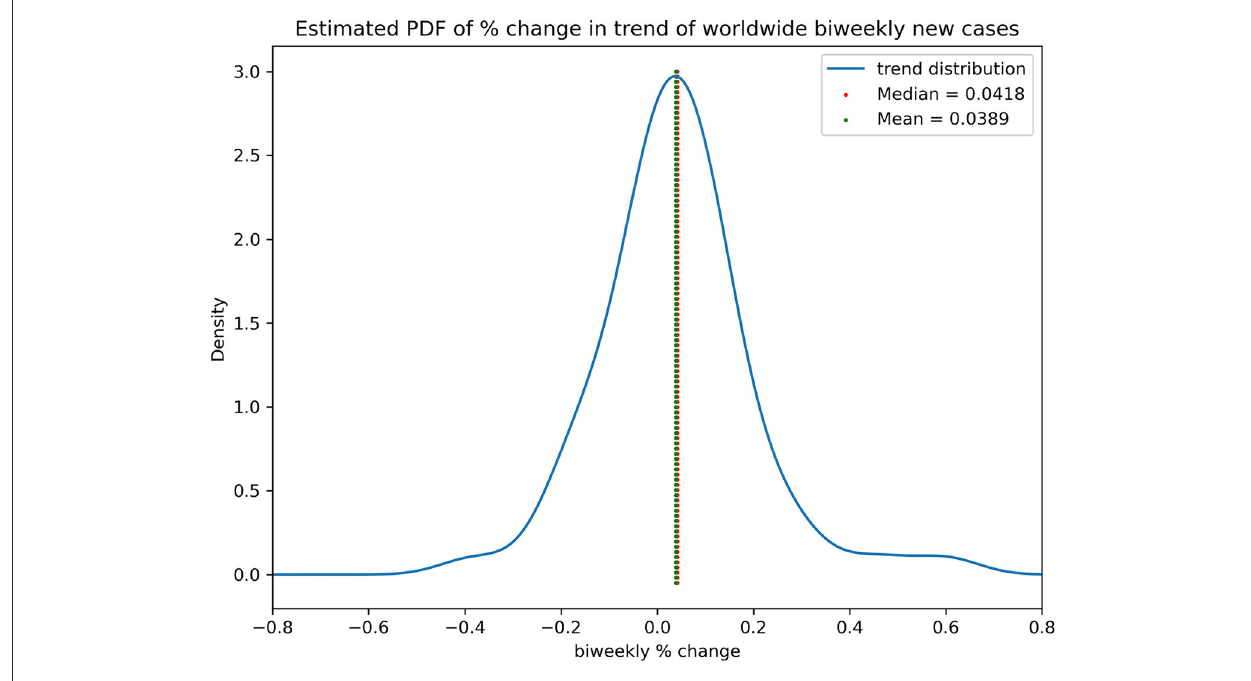
FIGURE3 Estimated PDF of % change in trend of worldwide biweekly new cases.